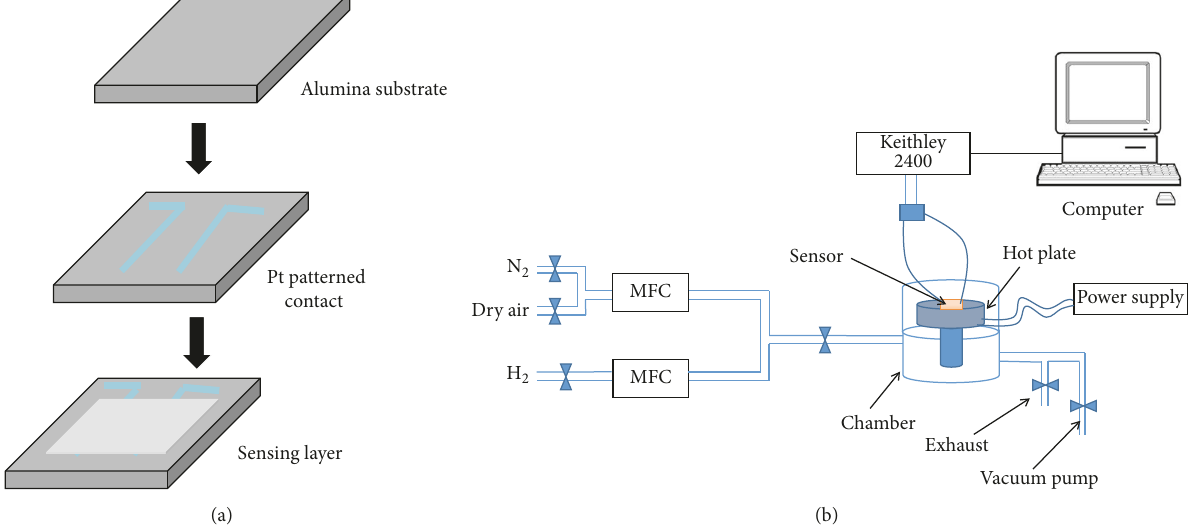
Figure 5: (a) Schematic diagram of sensor fabrication and (b) shows the schematic illustration of hydrogen sensor measurement instrument.